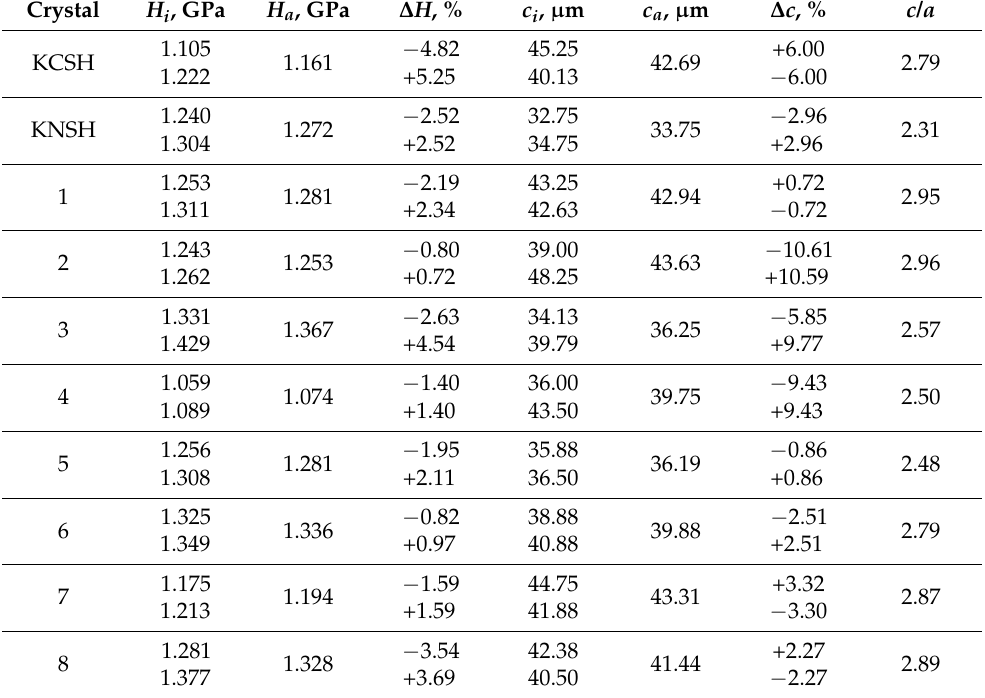
Table 2. Microhardness H and crack length c for (110) plane of KCNSH crystals at the load of 0.58 N.